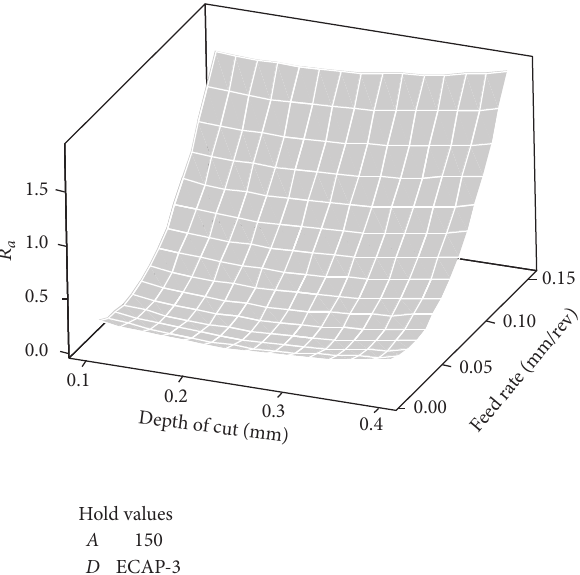
Figure 7: Response surface plot for 𝑅 𝑎 versus depth of cut and feed rate at a mean cutting speed of 150m/min.